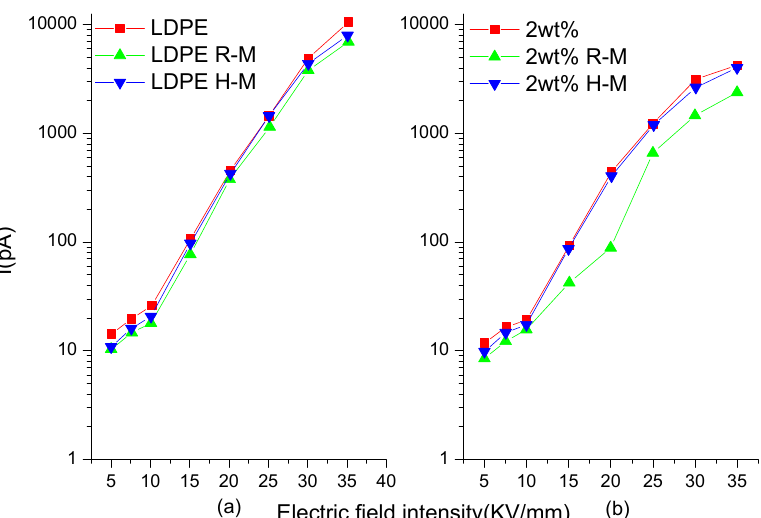
Figure 6. Conductivity current characteristic curves of LDPE ( a ) and composites ( b )at different magnetization temperatures. ( a ) is the conductivity current characteristic curve of LDPE. ( b ) is the conductivity current characteristic curve of BiFeO 3 /LDPE composite. Curves LDPE and 2 wt% indicate no magnetization treatment. R-M is room temperature magnetization. H-M is high temperature magnetization.